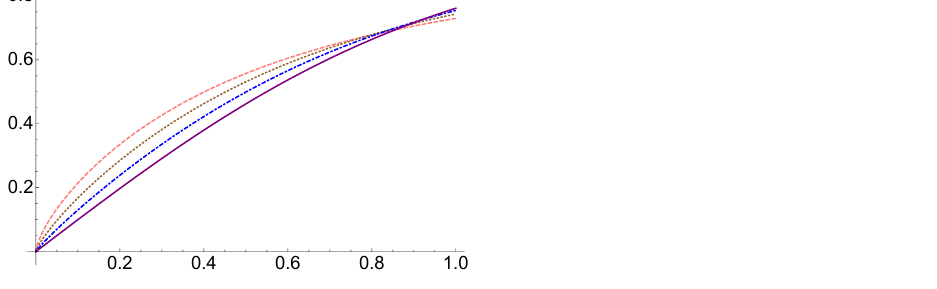
Figure 6. f ( x ) , where q = 0.7 (dashed), q = 0.8 (dotted), q = 0.9 (dashed-dotted), and exact solution q = 1 (continuous), with α = q , for Example